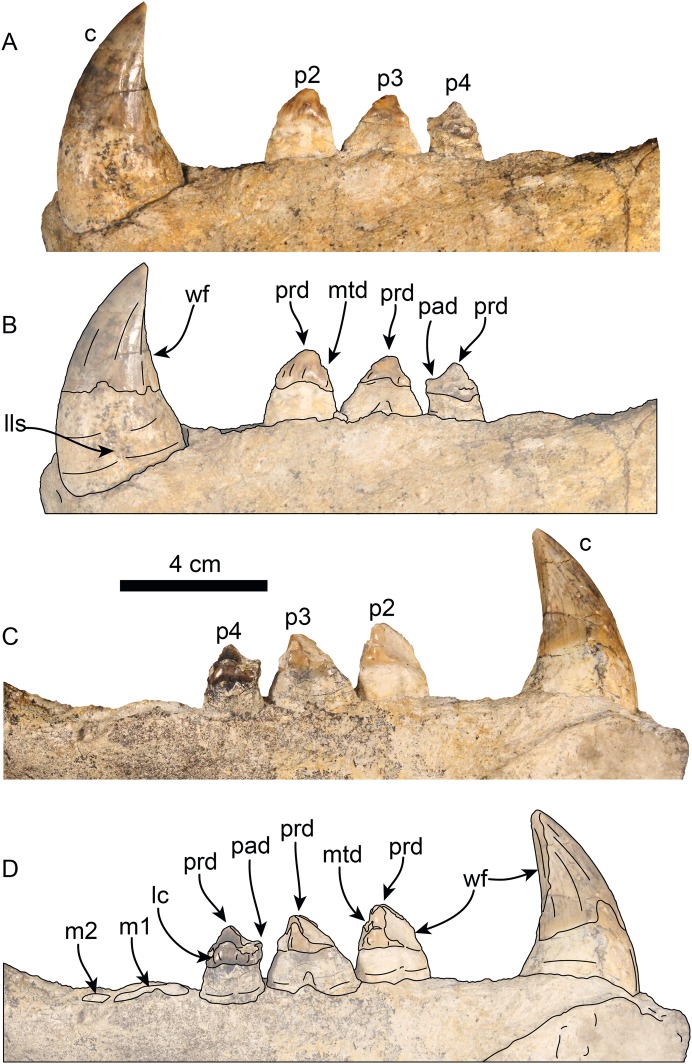
Lower dentition of Titanotaria orangensis n. gen. et sp. (OCPC 11141).Left lower dentition in labial (A–B) and lingual (C–D), views. Abbreviations: c, lower canine; lc, lingual cingulum; lls, lingual longitudinal sulcus; m1–2, lower molars 1–2; mtd, metaconid; p2–4, lower premolars 2–4; pad, paraconid; prd, protoconid; wf, wear facet.